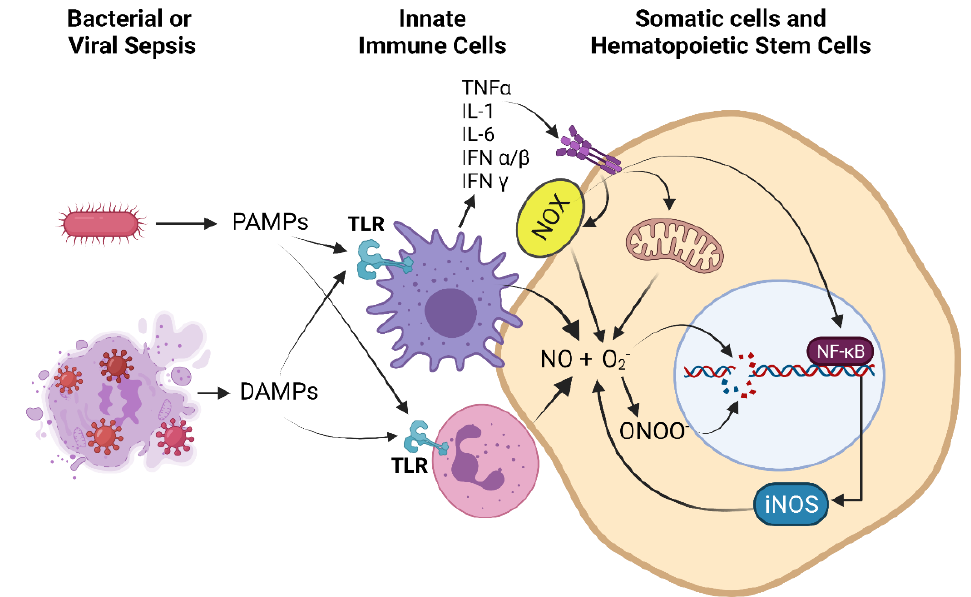
Figure 1. Immune cell activation during the hyper-inflammatory phase of sepsis, secretion and ampli- fication of cytokines, and up-regulation of RONS production by immune, somatic, and hematopoietic stem cells: Pathogen-associated molecular patterns (PAMPs) and danger-associated molecular pat- terns (DAMPs) generated by bacterial or viral sepsis activate pattern recognition receptors (PRRs) such as toll-like receptors (TLRs) of innate immune cells such as macrophages and neutrophils (shown), leading to ROS and RNS production as part of the pathogen killing response; however, these cells also adhere to vascular and parenchymal cells causing oxidant injury [71]. In addition, there is upregulation and secretion of pro-inflammatory cytokines (cytokine storm) such as tumor necrosis factor α (TNF α ), interleukin-1 (IL-1), interleukin-6 (IL-6), interferon α / β (IFN α / β ), and interferon γ (IFN γ ) from activated macrophages. Proinflammatory signaling leads to upregulation of NADPH oxidase (NOX), which produces reactive oxygen species (ROS) such as superoxide (O 2 − ), and upregulation of inducible nitric oxide synthase (iNOS), which produces nitric oxide (NO), in immune, somatic, and hem- atopoietic stem cells. NO and O 2 − can combine to produce peroxynitrite (ONOO − ). Elevated levels of these reactive oxygen and nitrogen species (RONS) lead to DNA damage and upregulation of the DNA damage response (DDR). Additional ROS such as H 2 O 2 , hydroxyl radical and hypochlorous acid also contribute to DNA damage but are not shown for clarity of presentation.